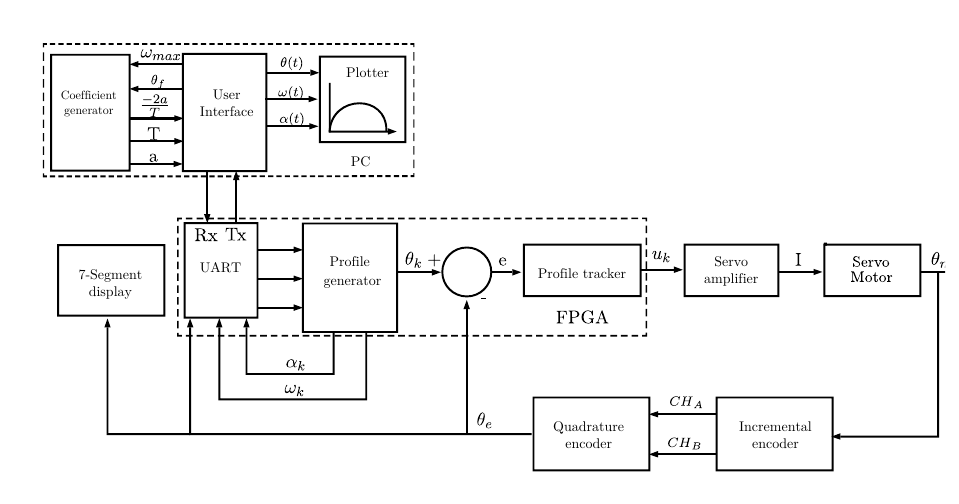
Figure 3. General block diagram of the implemented system.